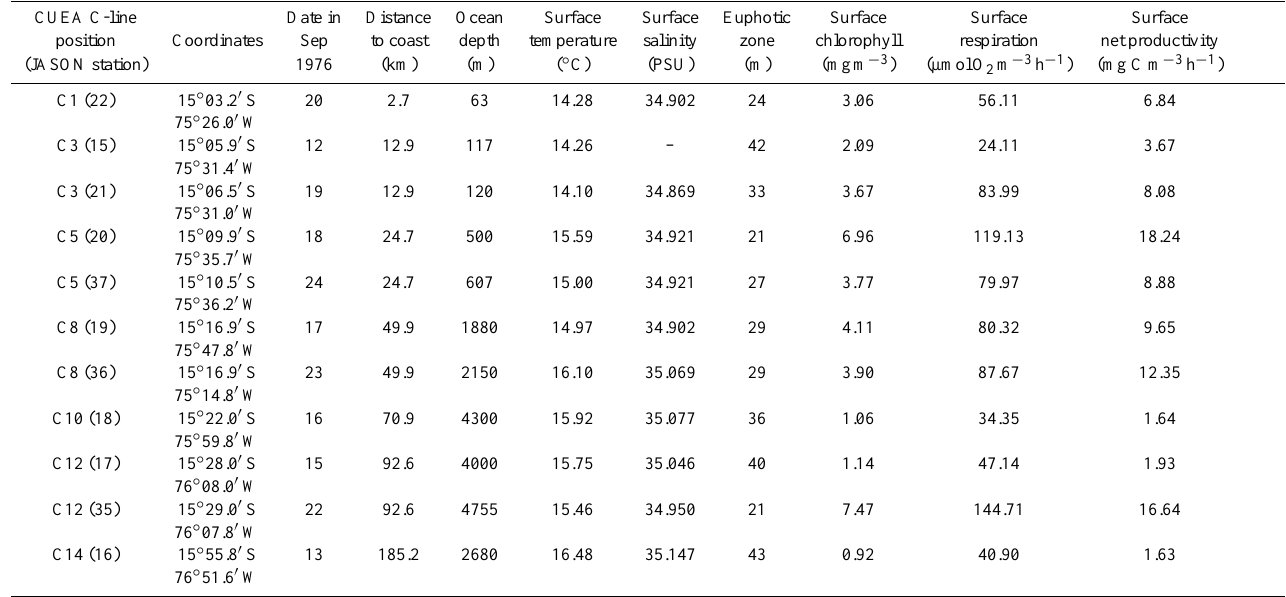
Table 1. Oceanographic characteristics of Peruvian upwelling C-line stations during Duke University’s JASON-76 R/V Eastward cruise no. E-5H-67. Ez depth is the 1% light level. Original data are in CUEA data reports (Kogelshatz et al., 1978; Packard and Jones, 1976). CUEA